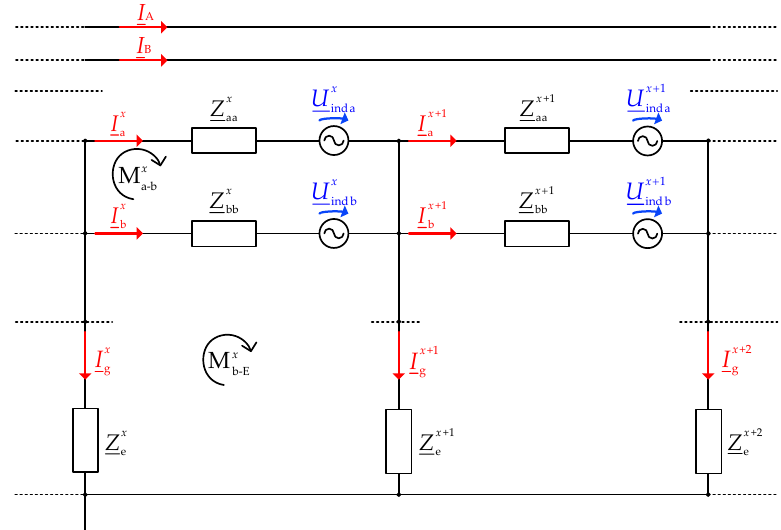
Figure 4. Chain conductor formed by the cable screens, shown for one stationary